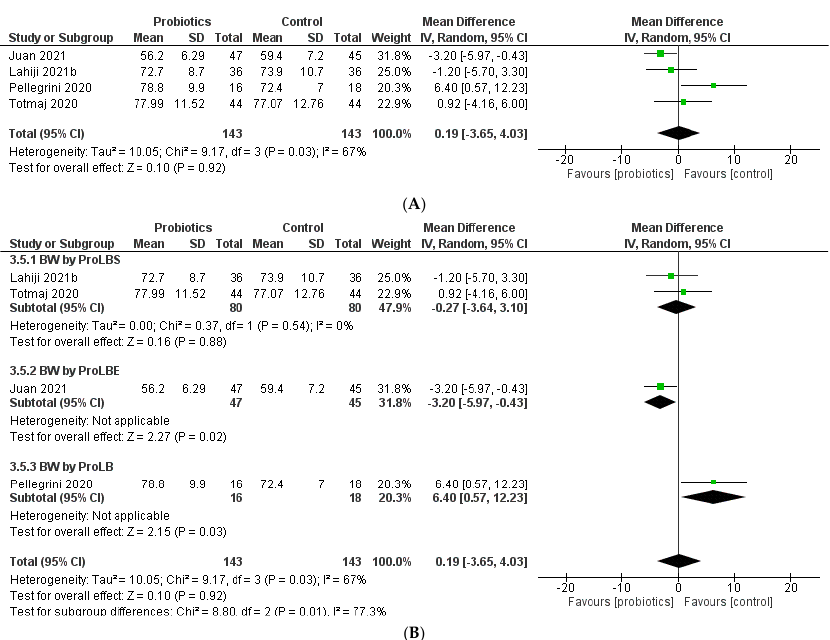
Figure 5. Meta-analysis of body weight ( A ) and body weight by probiotics type ( B ).